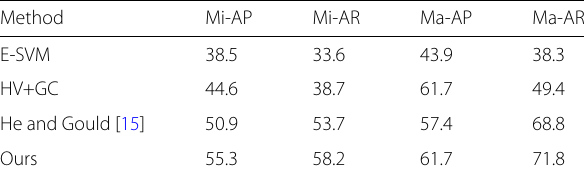
Table 3 Performance comparison of object labeling on Polo Method